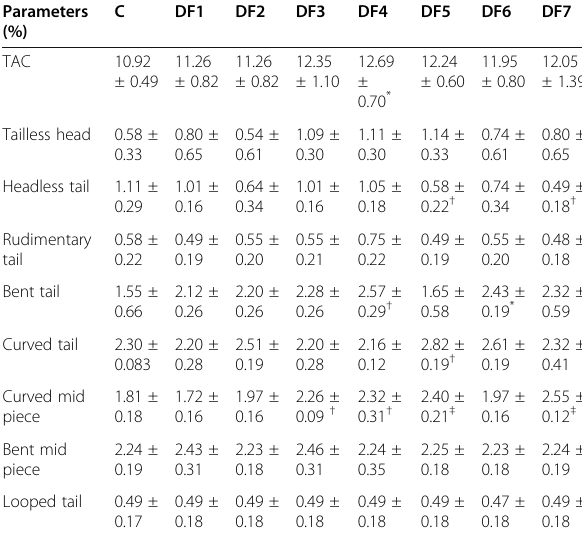
Table 8 Effect of chromatographic fractions of Waltheria indica Linn . root on sperm morphology of male Wistar rats (Mean ± SD, n = 5 for each group) Parameters (%)